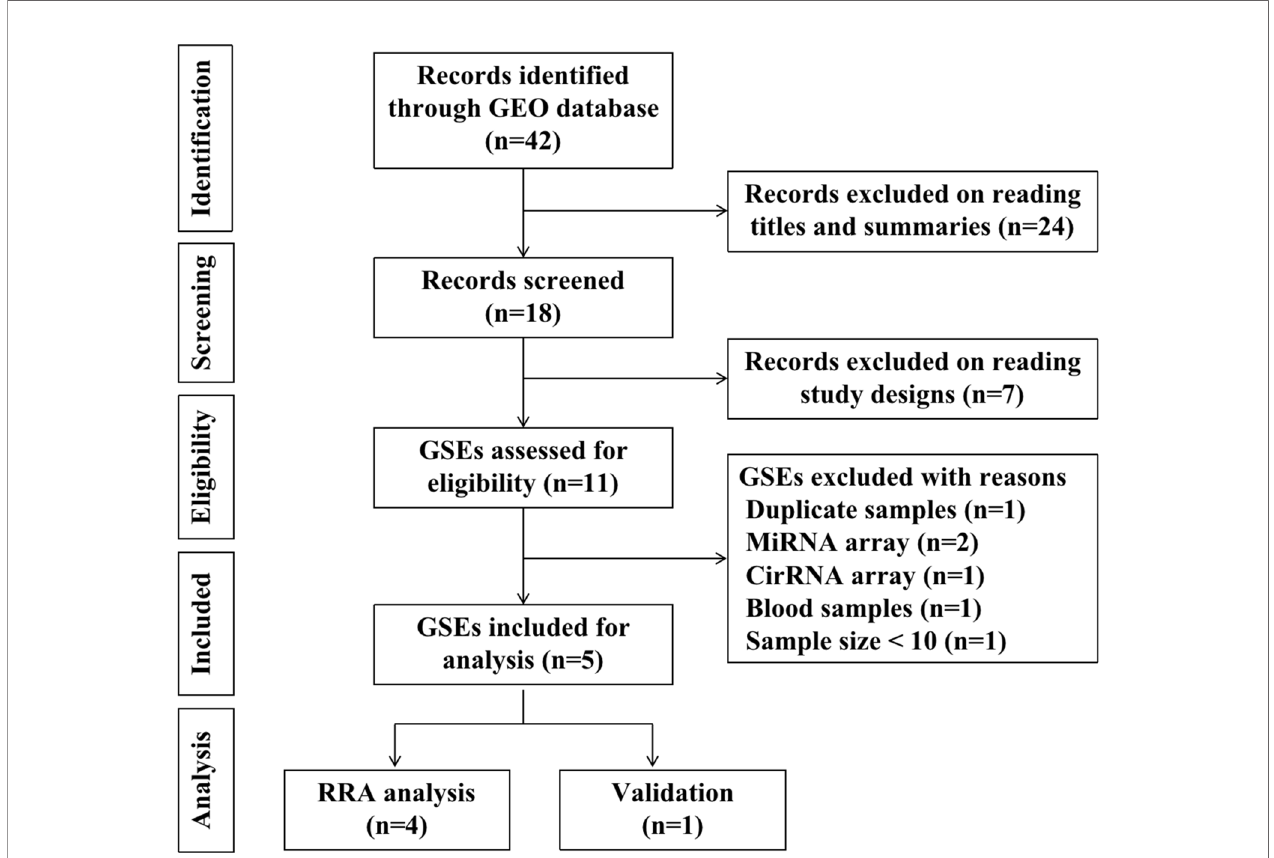
FIGURE 1 | The diagram of selecting GSE